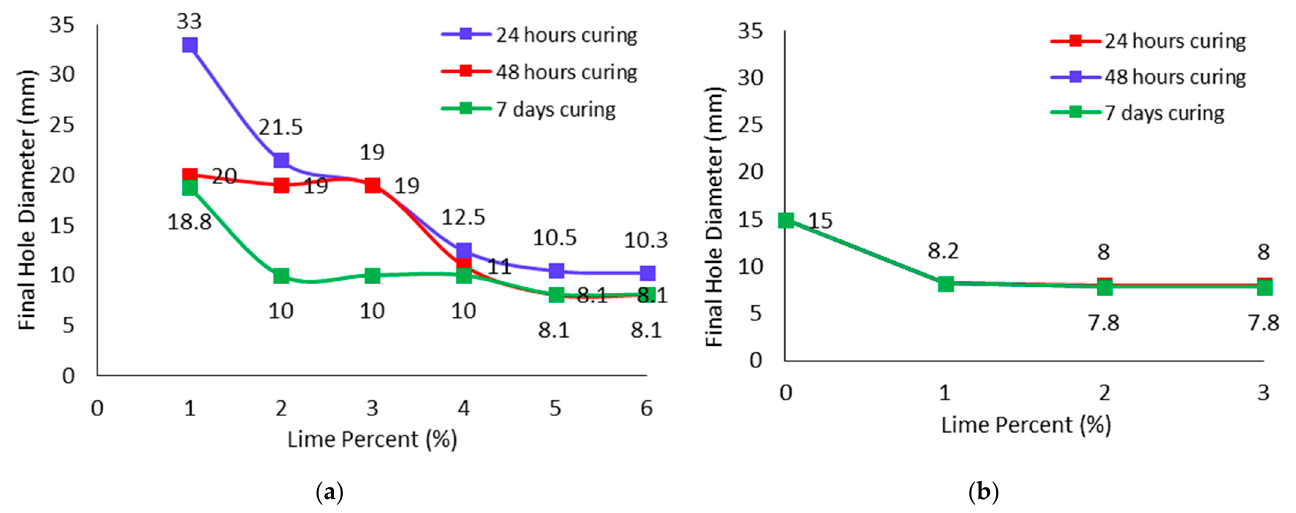
Figure 2. Graphical representation of final hole diameter ( ϕ f ) against lime percent (%) for ( a ) Soil #1 and ( b ) Soil #2 with di ff erent curing times.